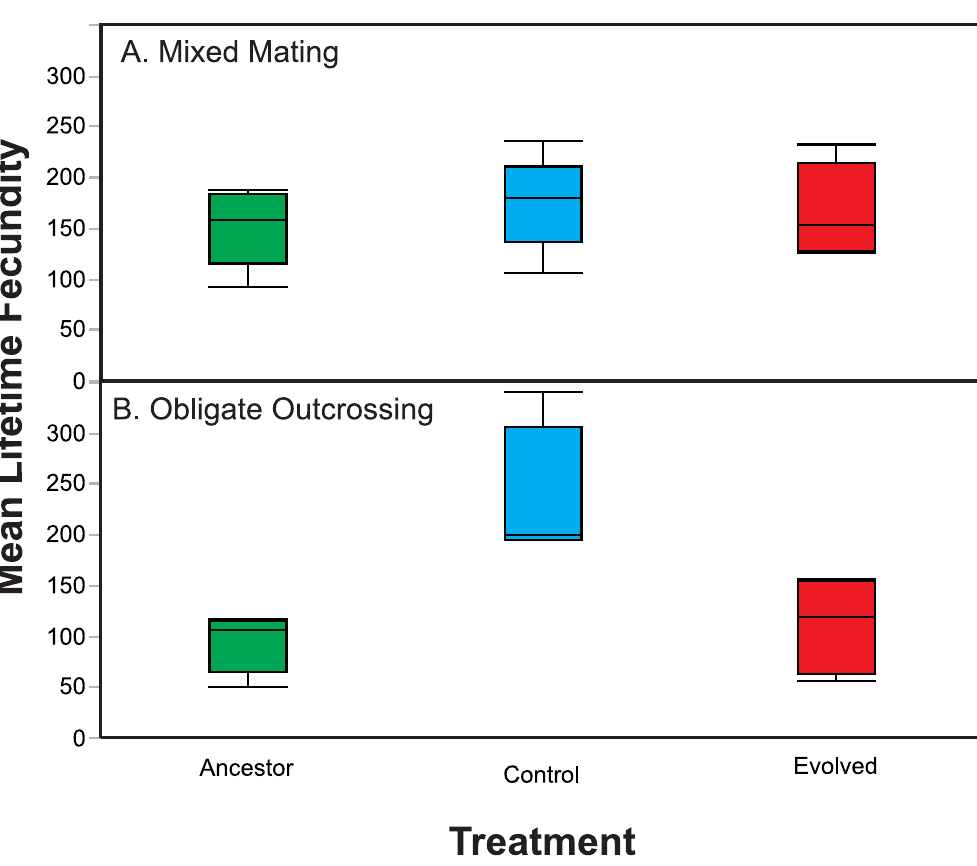
Fig 3. Host lifetime fecundity. Lifetime fecundity was assessedin the absenceof S . marcescens for Control, Evolution, and Ancestral populationsin the (A) mixed mating populationsand the (B) obligately outcrossing populations.Controlpopulationsexhibitedgreater levels of fecundity than the Ancestral and Evolution populations in obligatelyoutcrossingpopulations, but no treatment differences were detected in the mixed mating populations.